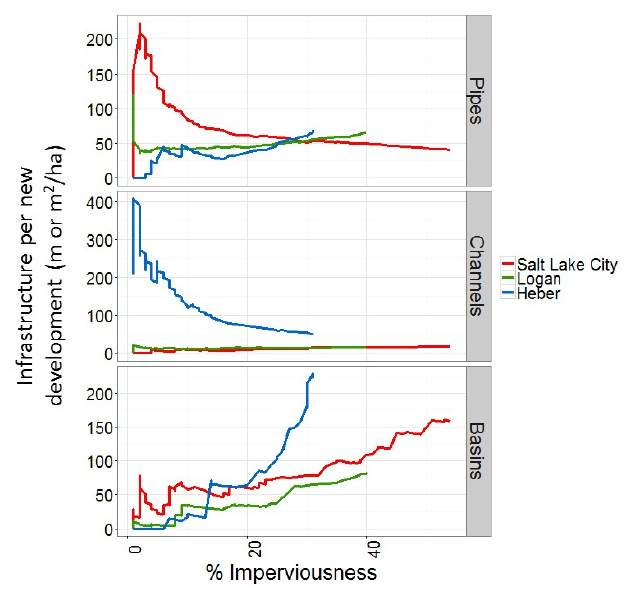
Figure 3. Changes in infrastructure density with % imperviousness (a proxy for urbanization) in Salt Lake City, Logan, and Heber City, UT.